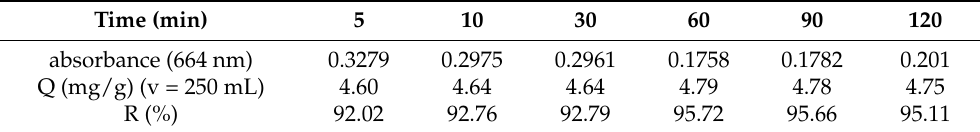
Table 3. Methylene blue adsorption